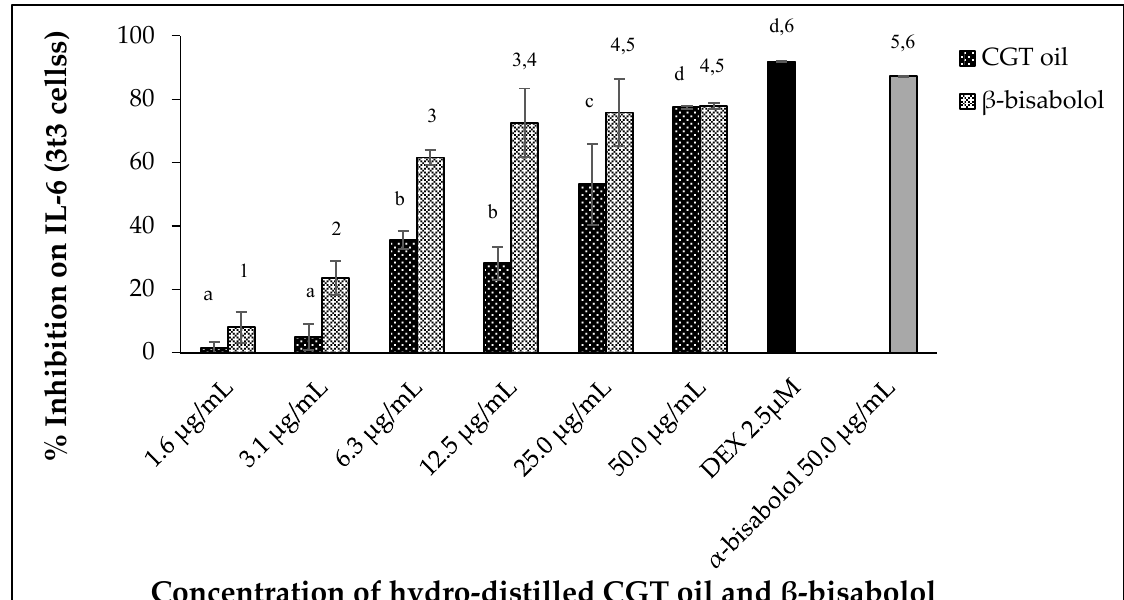
Figure 5. Effect of CGT oil and β -bisabolol dilutions on IL-6 production in 3t3 cells. Cells were exposed to test extracts or compounds for 1 h and then induced with 100 ng/mL lipopolysaccharide (LPS) for IL-6 production ( n = 3). Values are expressed as mean ± SD. Duncan’s multiple range test between average IL-6 production across the different concentrations indicates that dissimilar letters/numerals denote a significant difference ( p ≤ 0.05).